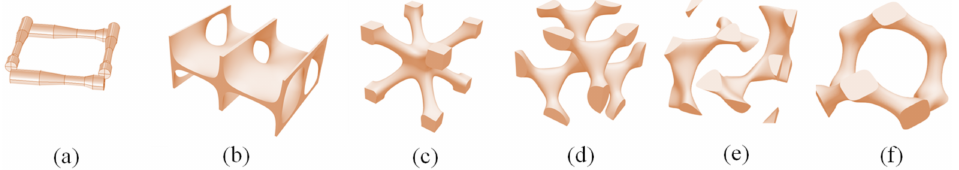
Figure 1. Diagram of the unit periodic structure of ( a ) commercial, ( b ) CLP, ( c ) IWP, ( d ) D, ( e ) L, and ( f ) IW spacers.